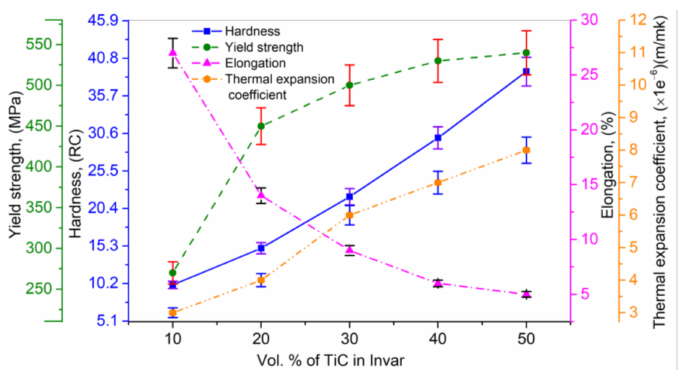
Figure 13. Effect of vol.% of TiC in invar: hardness, yield strength, elongation, and thermal expansion coefficient; based on the data from